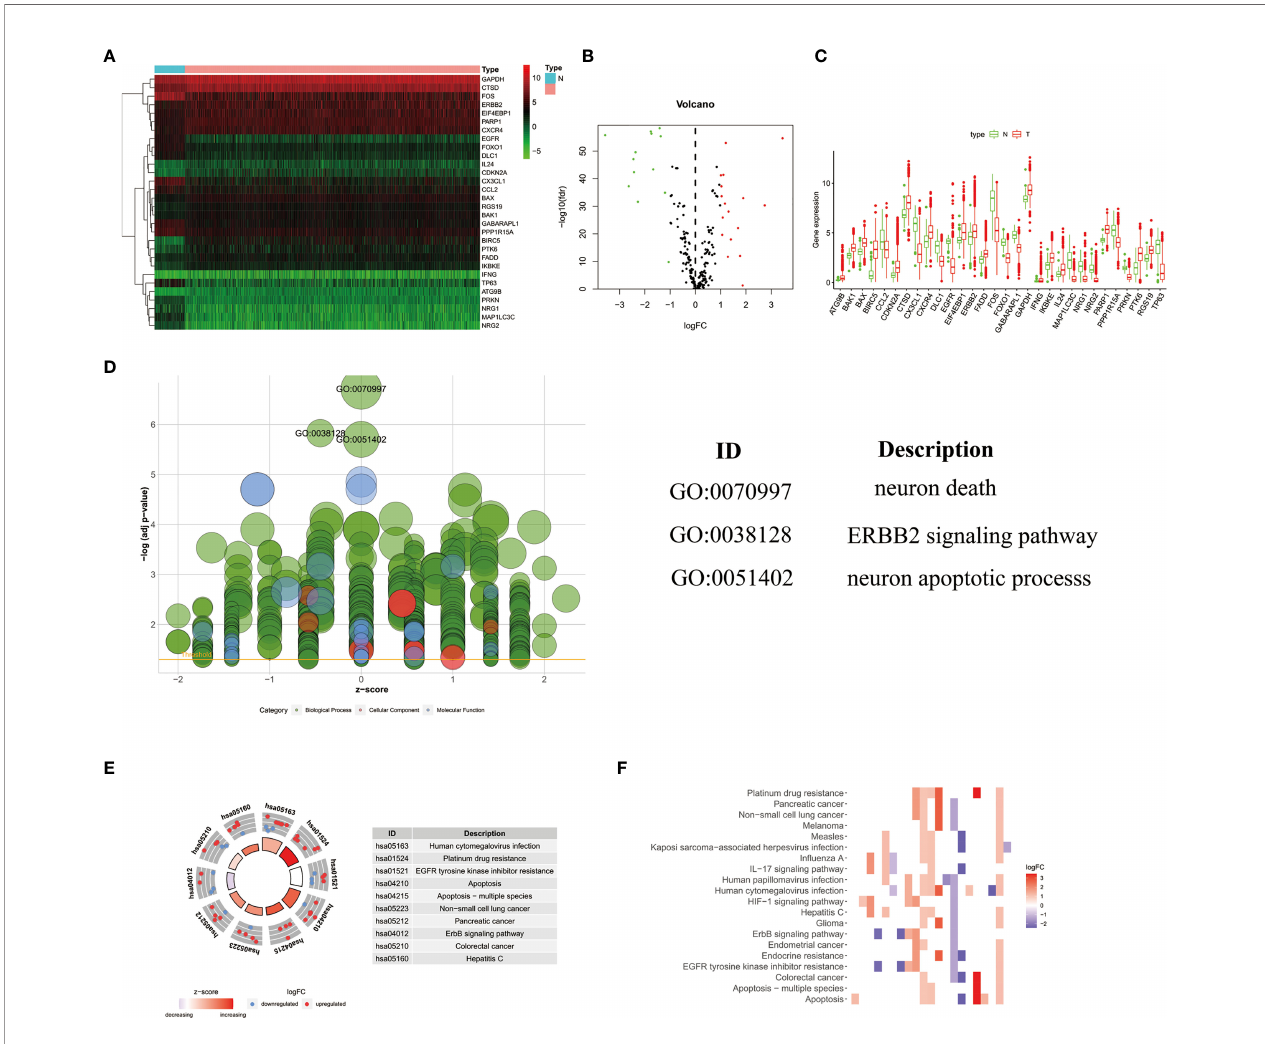
FIGURE 1 | The heatmap (A) and volcano map (B) showed 30 differentially expressed autophagy-related genes in breast cancer tissues. Red represented high expression level, green represented low expression level, and black represented no signi fi cant difference. (C) The box plot showed the expression patterns of 30 differentially expressed ARGs. Red dots indicated tumor tissues, and green dots indicated normal tissues. (D) GO analysis showed the biological processes, cellular components, and molecular functions involved in ARGs; the green, pink, and blue bubbles represented biological processes, cellular components, and molecular functions, respectively. (E, F) The potential enrichment pathways of ARGs in breast cancer were obtained by KEGG analysis.